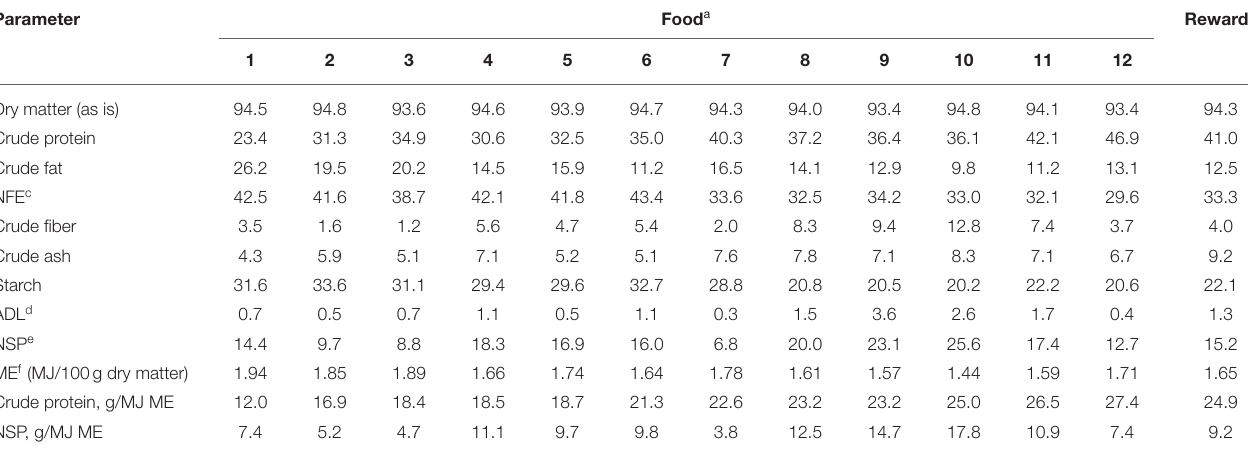
TABLE 2 | Analyzed chemical composition of commercial dry extruded foods (g/100g dry matter unless defined differently). Parameter Food a Reward b